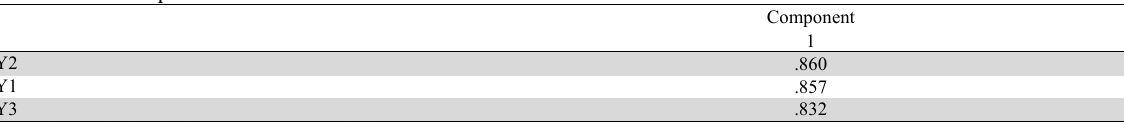
The results of component